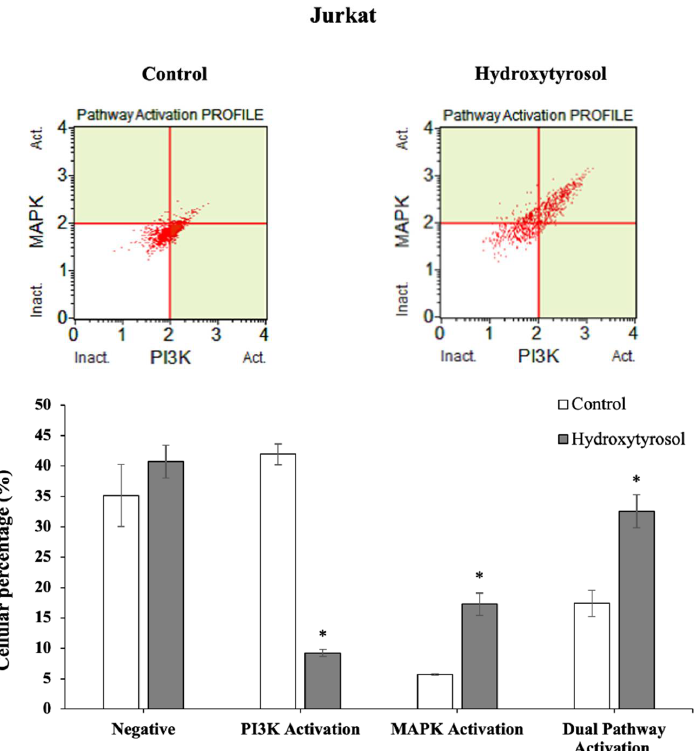
Figure 7. AKT/PI3K and ERK 1/2 /MAPK dual pathway determination was performed according to the MuseTM PI3K/MAPK Dual Pathway activation kit. Graphs correspond to Jurkat cells. Treatments included cells not treated and cells incubated with IC 50 of HT for 24 h. Top: dot plots show a representative experiment of the treatments. Bottom: represents, using bar diagrams, the percentages of non-activated cells and cells activated with PI3K, MAPK and Dual pathway. Values are expressed as mean ± SEM ( n = 12). The asterisk indicates significant differences in the different activated pathways between control and treated cells ( p < 0.001). ERK1/2, Extracellular regulated kinase ½ (Protein-serine/threonine kinases); MAPK, Mitogen-activated protein kinase; AKT/PI3K, Protein kinase B/Phosphoinositide 3-kinase.